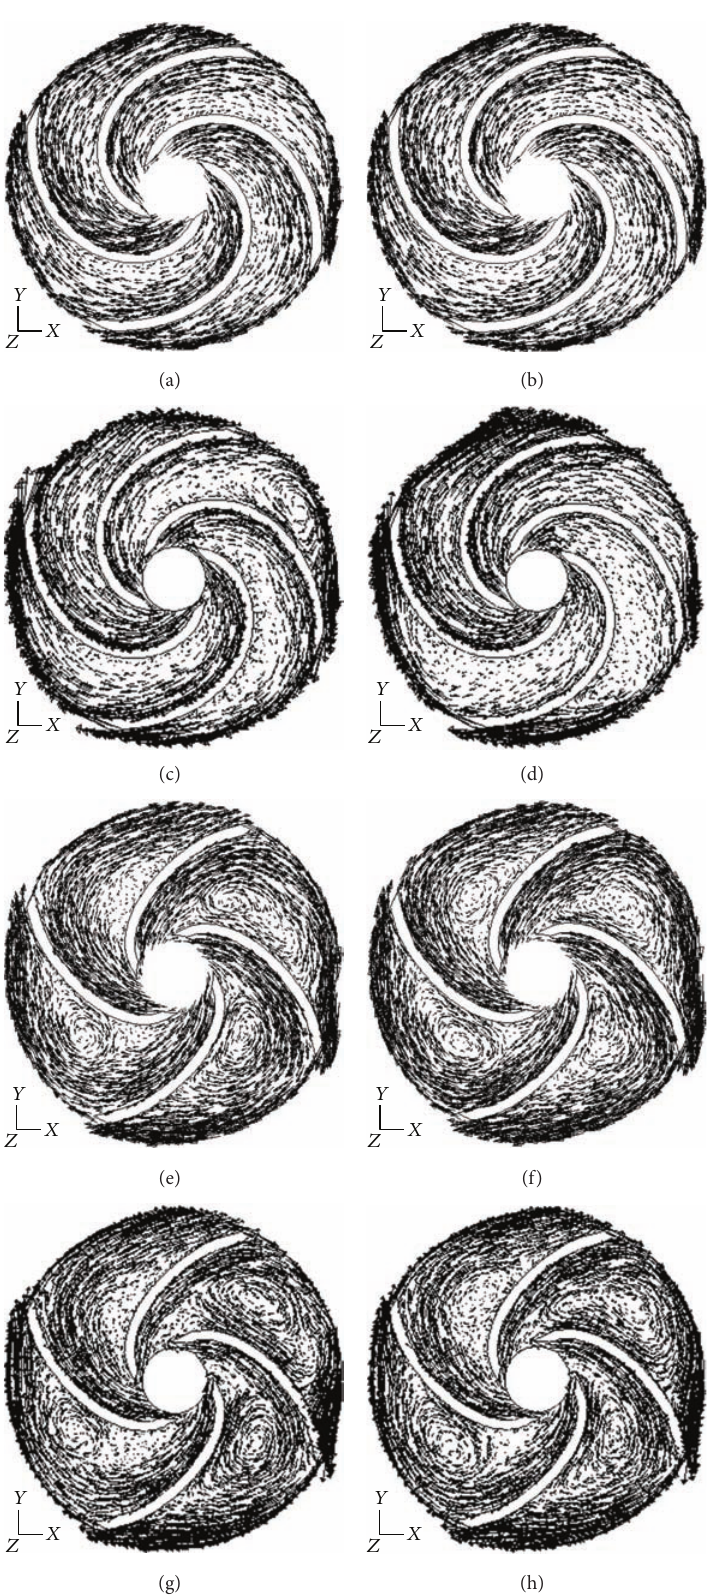
Figure 11: Relative velocity vectors of flow in mid-span plane of the impellers with 𝛽 2𝑏 = 20 ∘ , 44 ∘ at 𝑄 = 3.4, and 6.0 L/s (BEP), (a)–(d) for 𝛽 2𝑏 = 20 ∘ , (e)–(h) 𝛽 2𝑏 = 44 ∘ , (a), (b), (e), and (f) for BEP, and (c), (d), (g) and (h) for low flow rate 3.4 L/s, left-water (1cSt), and right-oil